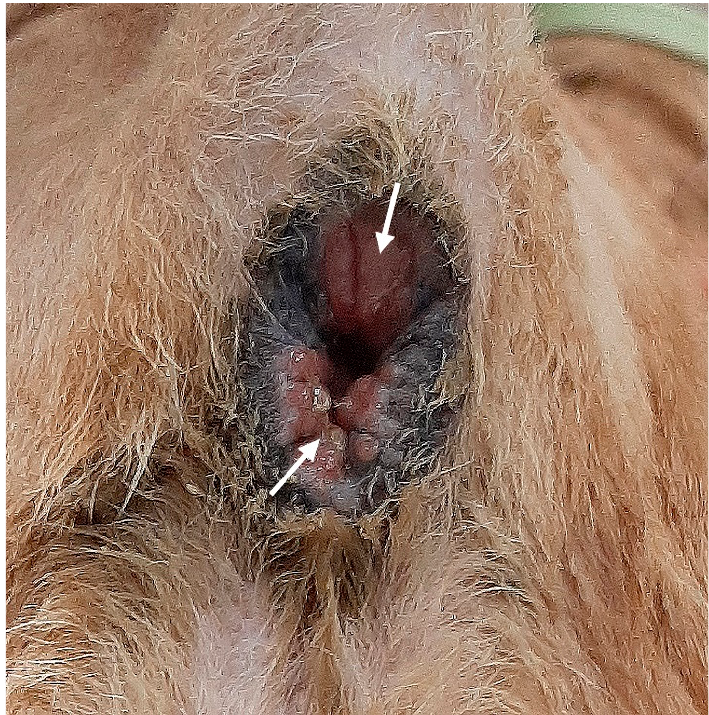
Figure 1. Anal area with sphincter incompetence. The anal orifice is abnormally widened with the rectal mucosa (white arrows) exposed outside.